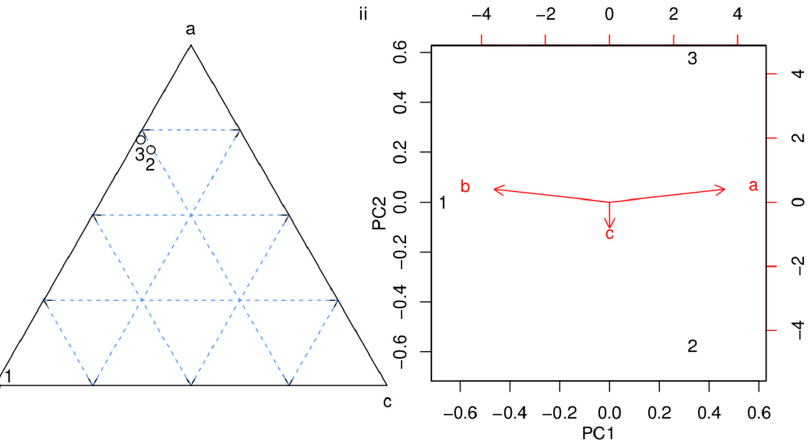
“ Figure 1. Graphical output of Section 3. Black circles mark 20 synthetic Al 2 O 3 , (CaO + Na 2 O) and K 2 O compositions, drawn from a logistic normal distribution. The blue square marks the arithmetic mean, which falls outside the data cloud. The blue polygon marks a 2- σ confidence polygon, which plots outside the ternary diagram, in physically impossible negative space. The red square represents the logratio mean, which firmly plots inside the data cloud. The red confidence envelope marks a 95% confidence region calculated using Aitchison’s logratio approach. This confidence envelope neatly fits inside the ternary diagram and tightly hugs the